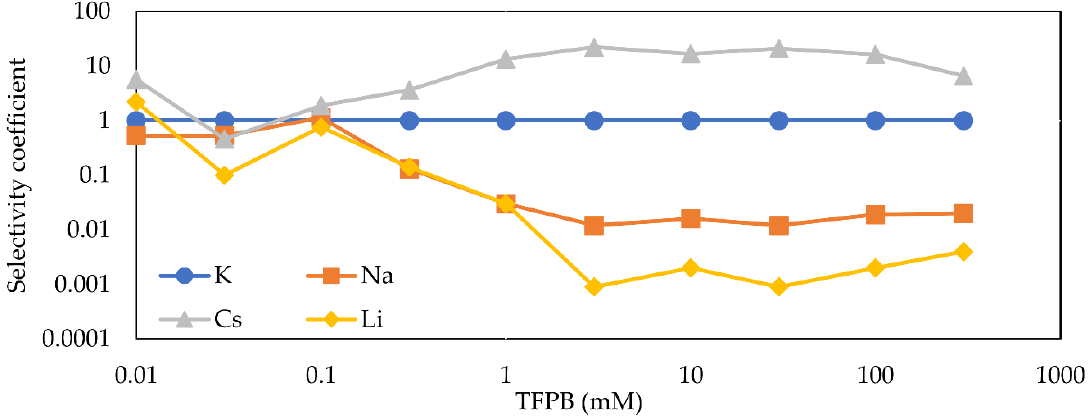
Figure 10. Variation of the selectivity coefficient ( 𝑘 (cid:3012),(cid:3037)(cid:3043)(cid:3042)(cid:3047) ) with different TFPB concentrations.